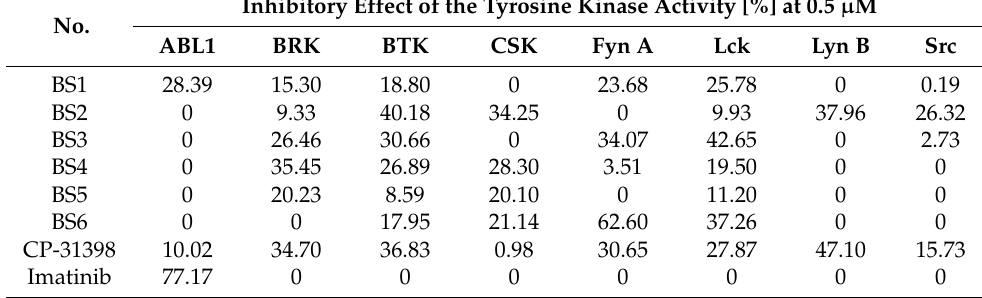
Table 2. The anti-enzymatic activity of the tested styrylquinazolines against a panel of eight non- receptor tyrosine